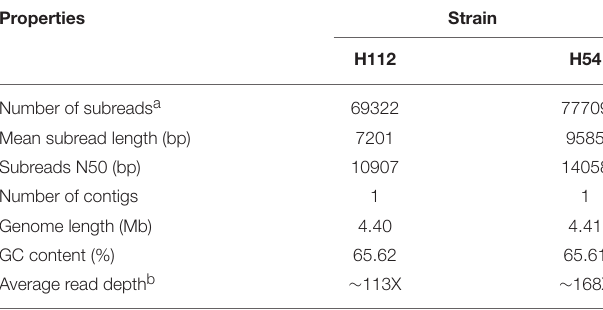
TABLE 1 | Results of whole-genome sequencing and